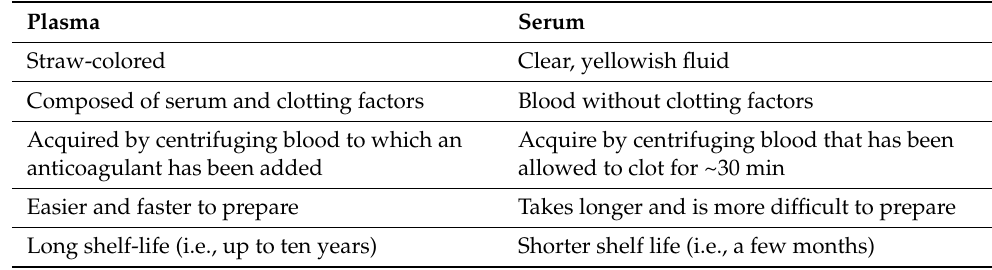
Table 1. Comparison of plasma and serum. Plasma Serum Straw-colored Clear, yellowish fluid Composed of serum and clotting factors Blood without clotting factors Acquired by centrifuging blood to which an anticoagulant has been